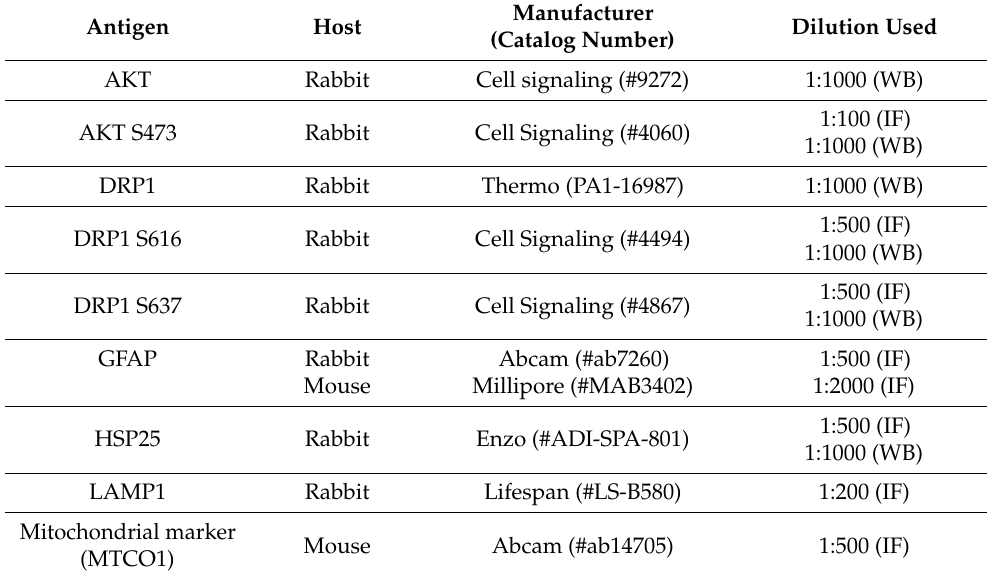
Table 1. Primary antibodies used in the present